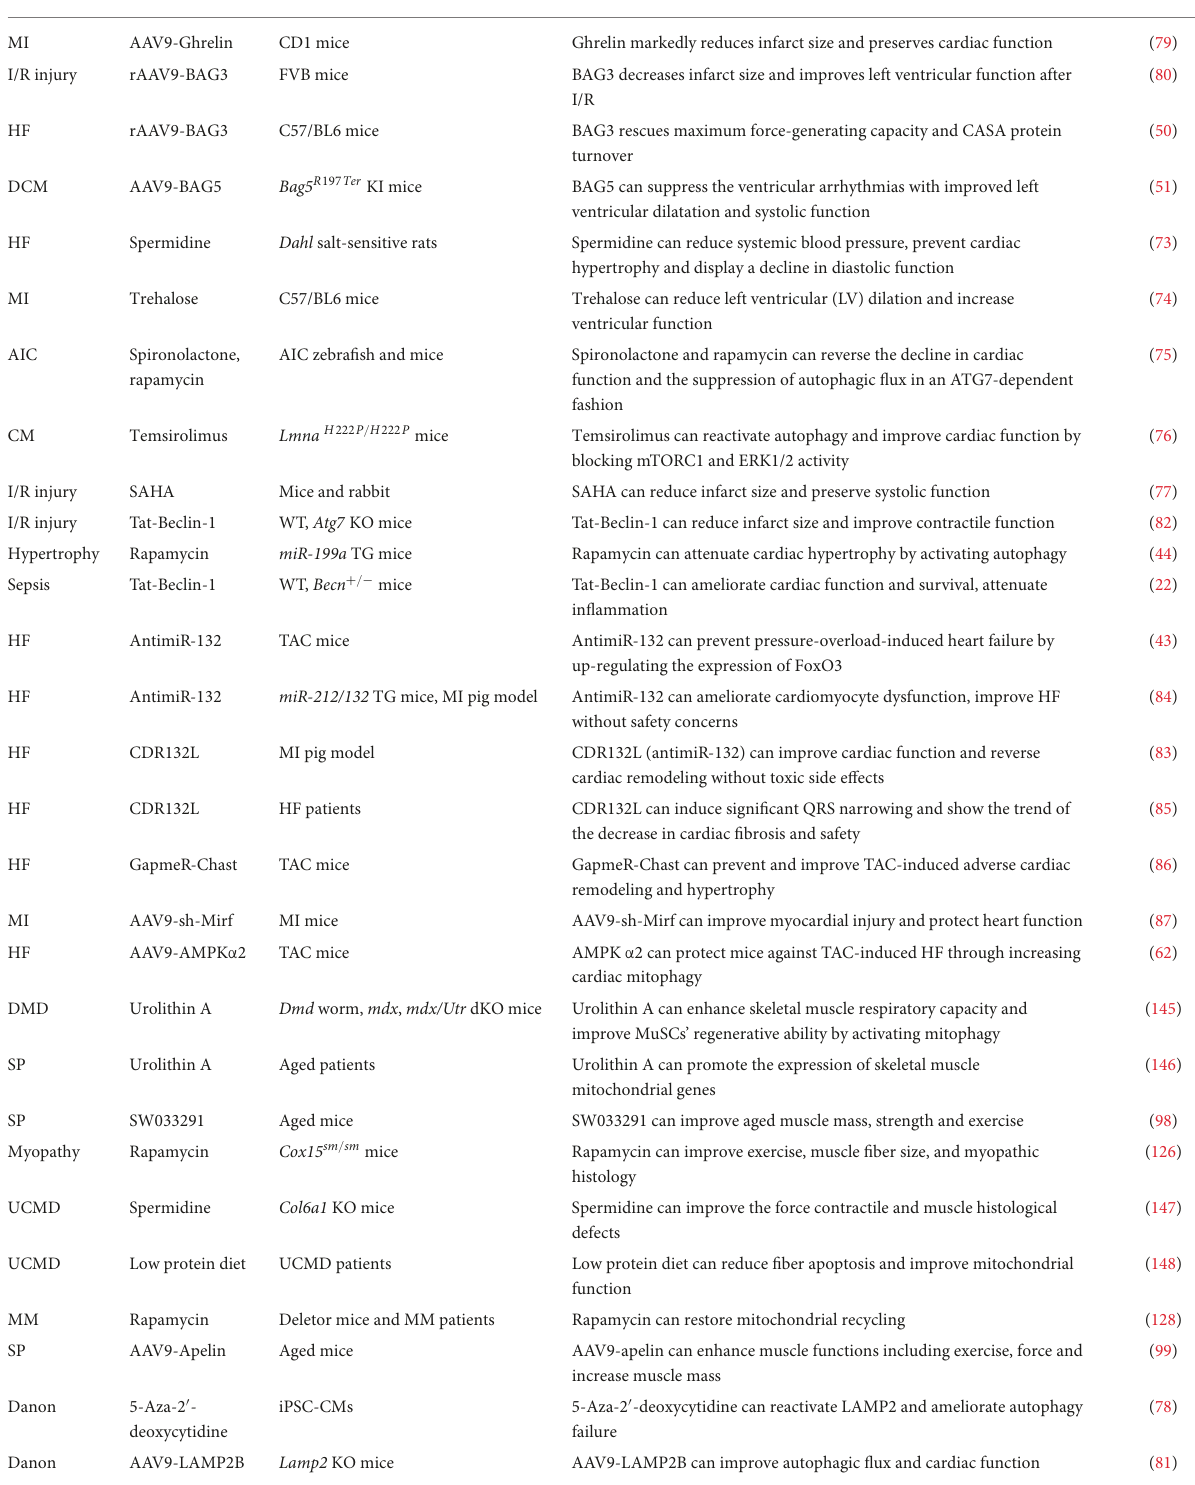
TABLE 2 Targeting autophagy for striated muscle disease treatment.